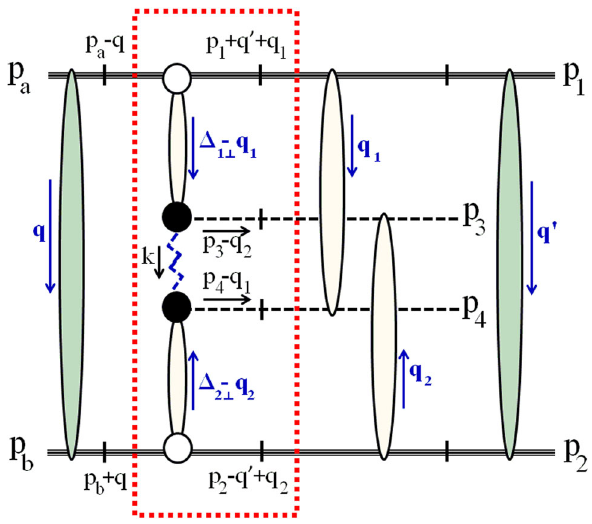
Fig. 16 Total amplitude of the process of double pion LM CEDP p + p → p + π + + π − + p with detailed kinematics. proton–proton rescatteringsintheinitialandfinalstatesaredepictedasblackblobs,and pion–protonsubamplitudesareshownasshadedblobs.Allmomentaare shown. The basic part of the amplitude, M 0 (see Eq. (5)), without cor- rections is circled by a dotted line. Crossed lines are on mass shell. Here Δ = Δ − q − q (cid:5) , Δ = Δ + q + q (cid:5) , ˆ t = k 2 = (Δ 1 ⊥ 1 2 ⊥ 2